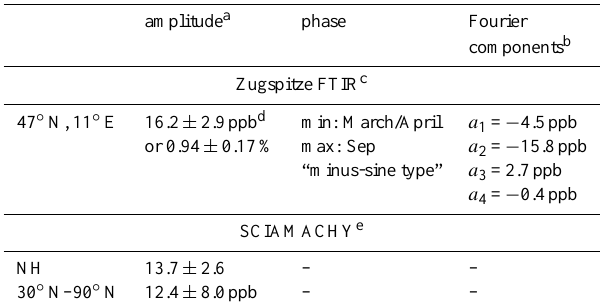
Table 10. Parameters describing the seasonality of column- averaged mole fractions of